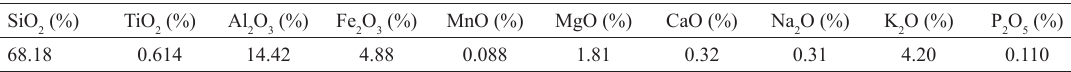
Table 3: Chemical composition of clay